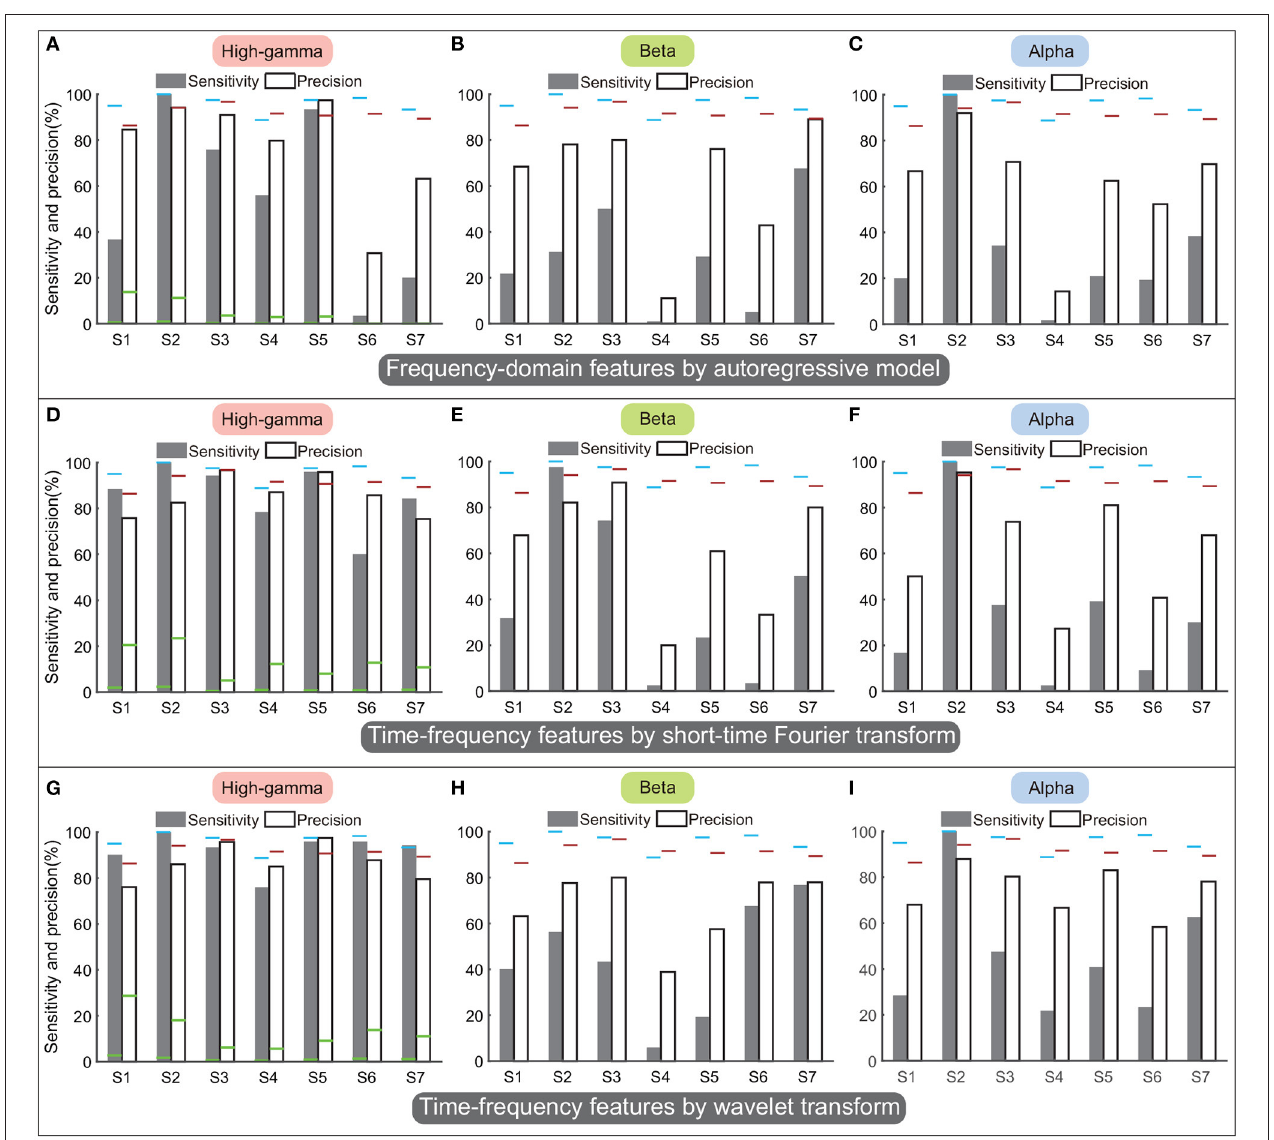
FIGURE 11 | Performances of frequency-domain or time-frequency features calculated by autoregressive model, short-time Fourier transform, and wavelet transform. Panels (A–C) display the performances of autoregressive model. Panels (D–F) display the performances of short-time Fourier transform. Panels (G–I) display the performances of the wavelet transform. By each approach, the sensitivity and precision were calculated in the high-gamma, beta, and alpha bands separately. The results were compared with the performances of the above four-type feature combination ( Figure 9C ), where the blue horizontal line and the red horizontal line indicate the sensitivity and the precision calculated using the four-type feature combination, respectively. The green horizontal lines of each subject in (A,D,G) indicate the chance levels of the sensitivity and the precision corresponding to the